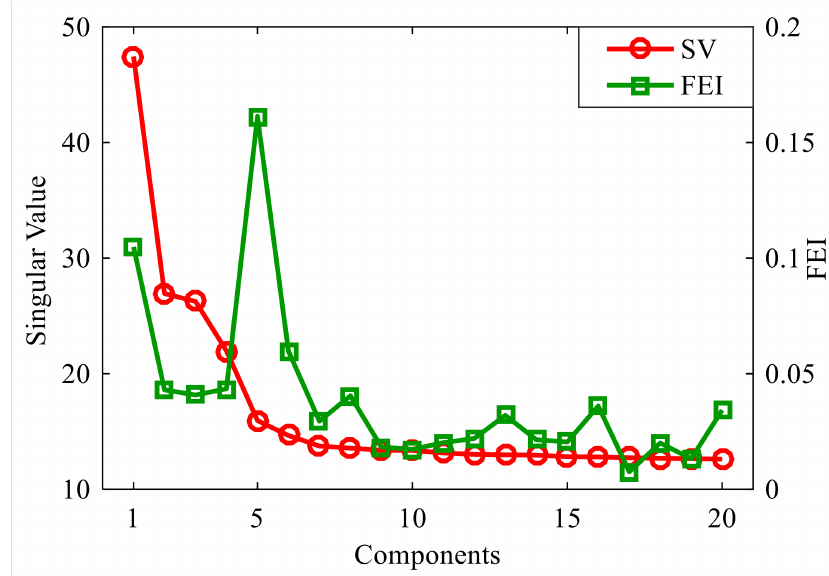
Figure 8. Comparison between singular value and